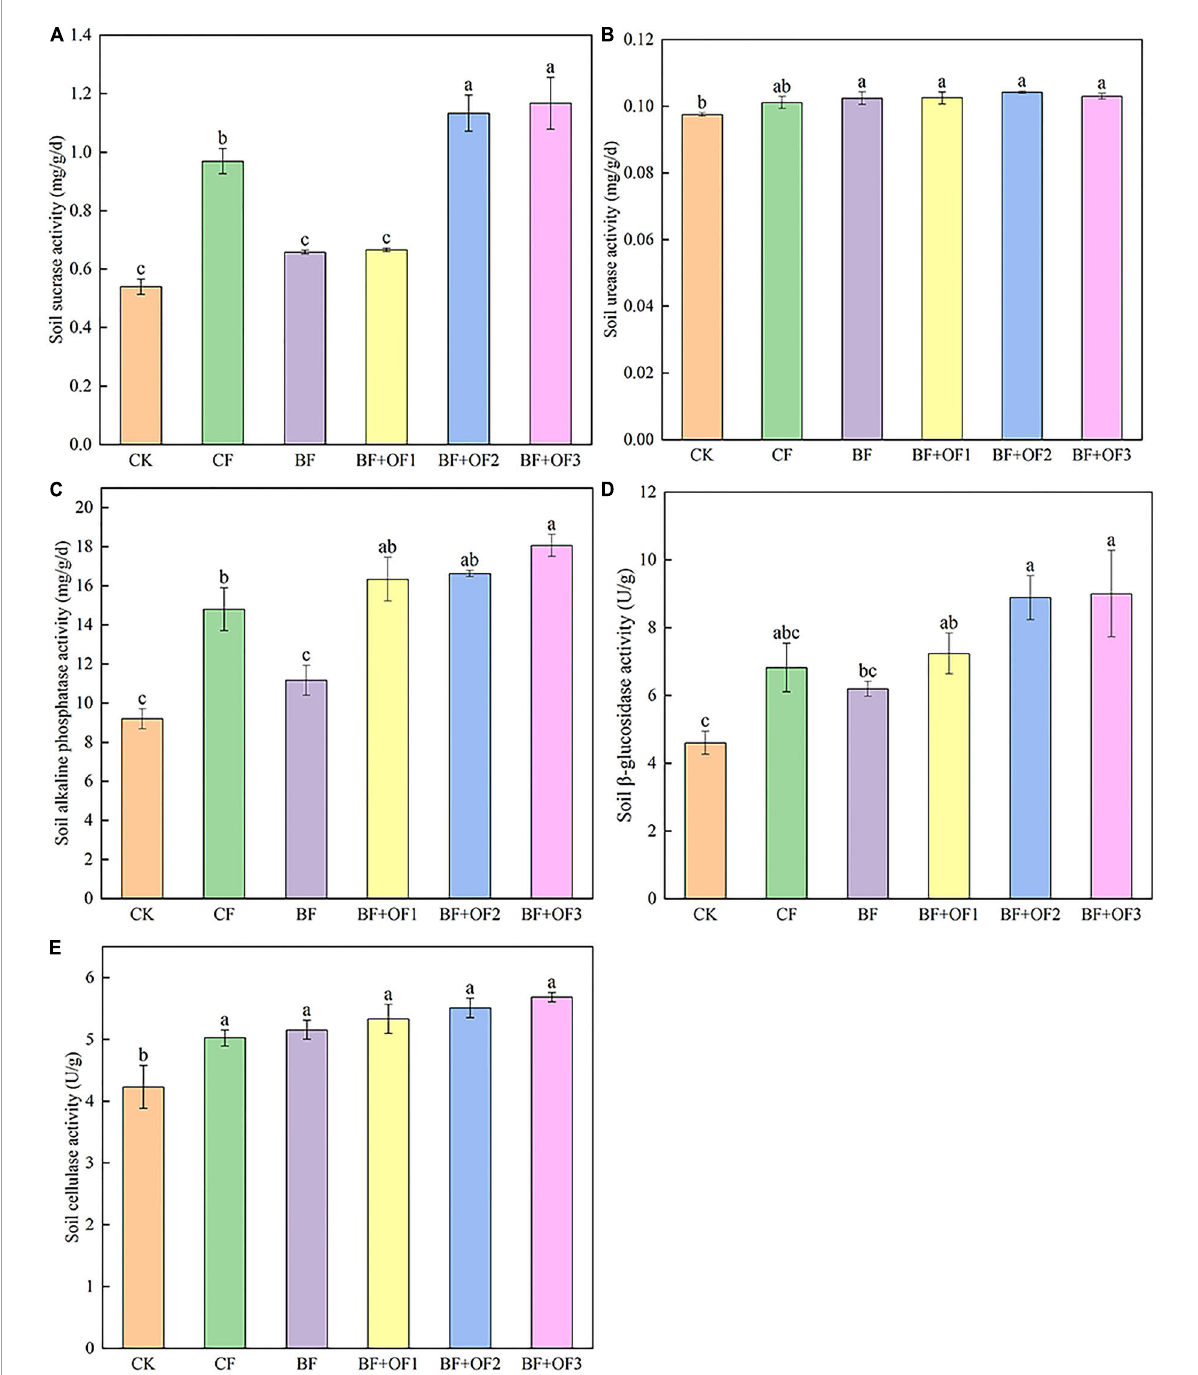
FIGURE1 Soil enzyme activities under different fertilization treatments. The sucrase activities (A) , urease activities (B) , alkaline phosphatase activities (C) , β -glucosidase activities (D) and cellulase activity (E) . CK, no fertilizer, CF, chemical fertilizers (conventional dosage for this region); BF, balanced fertilizer (70% of total chemical fertilizer); BF + OF1, BF + OF2, and BF + OF3, balanced fertilizer plus 3,000, 6,000, and 12,000 kg · ha − 1 bio-organic fertilizer, respectively. Each histogram represents the mean ± standard error (SE) of three independent biological experiments ( n = 3). Different letters above the bars indicate statistically significant differences by Duncan’s test ( p <